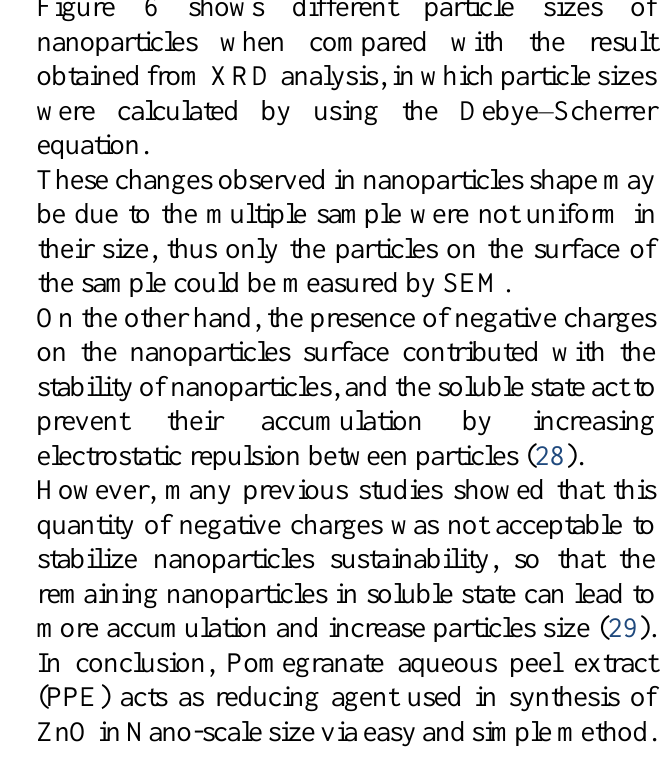
Figure shows different particle sizes